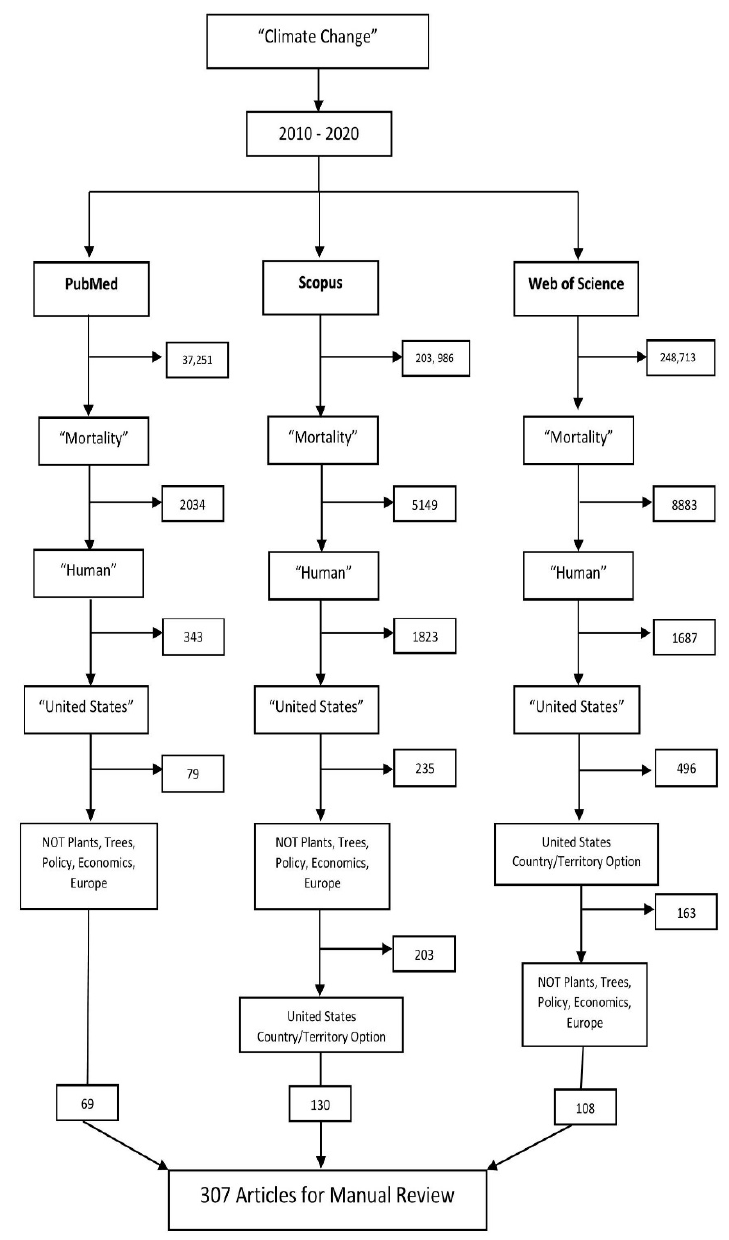
Figure 1. The number of articles retrieved from three databases: PubMed, Scopus, and Web of Science using the term “Climate Change”. The keywords used for filtering are shown inside the quotes.